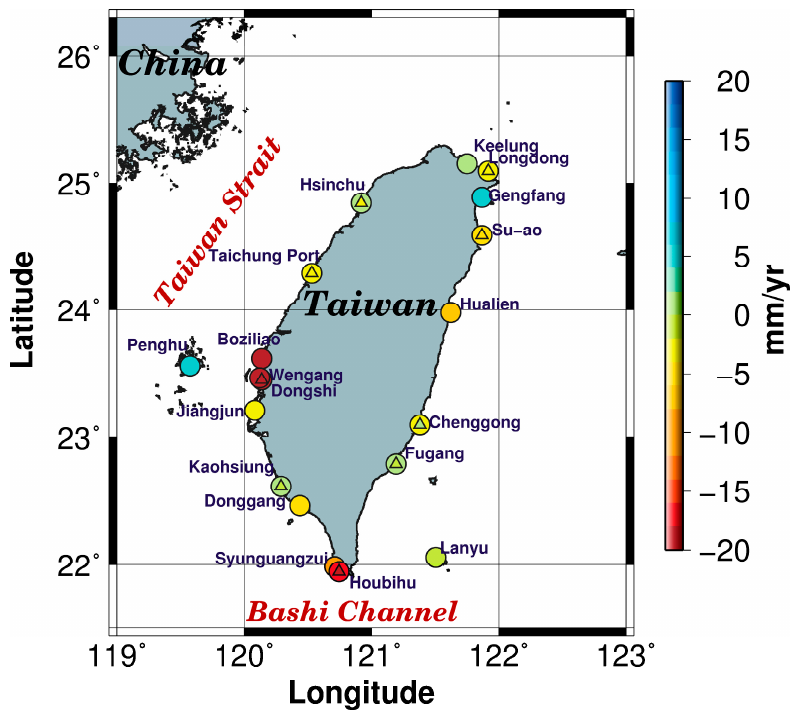
Figure 4. Vertical land motion trends derived from combining data from altimetry and tide gauges (circle) and from GPS (triangle).